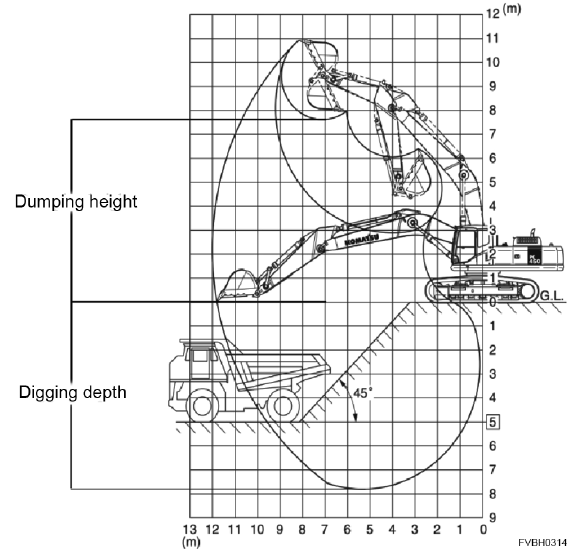
Fig. 1. A normal material loading operation by using backhoe shovel and dump track